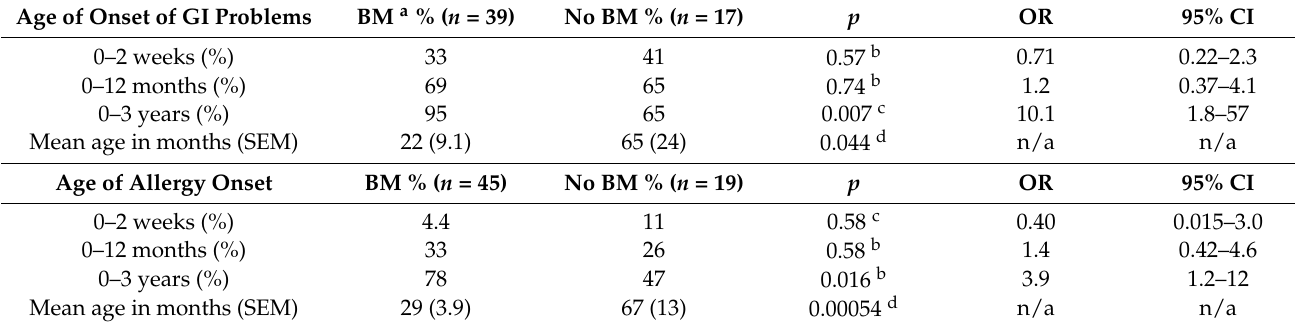
Table 8. Timeframe of GI problems and allergies in FXS study population as a function of breast milk. Age of Onset of GI